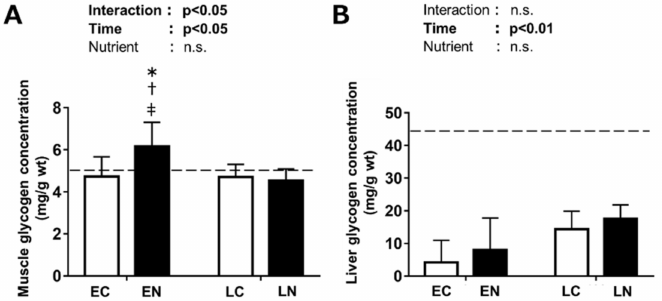
Figure 3. Mouse plantaris muscle ( A ) and liver ( B ) glycogen concentrations at 30 min after oral intake of nutrient solution (1.2 mg / g bw glucose and 0.4 mg / g milk casein, black) or water (control, white). The early nutrient-treated (EN) and the time-matched control (EC) groups were provided solution immediately after the exercise; the late nutrient-treated (LN) and the time-matched control (LC) groups were provided solution at 180 min after the exercise. Values are mean ± SE. n = 6 or 7 per group. Dashed lines indicate the baseline values (sedentary). * p < 0.05 vs. the EC, † p < 0.05 vs. the LC, ‡ p < 0.05 vs. the